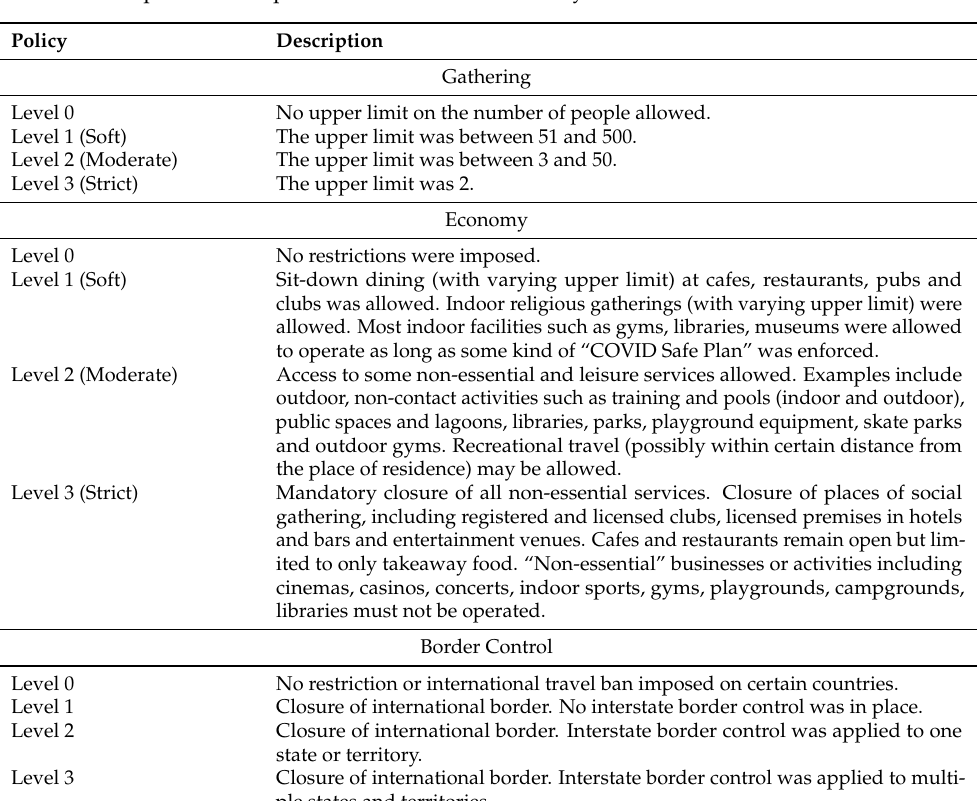
Table 1. Descriptions of the policies considered in the